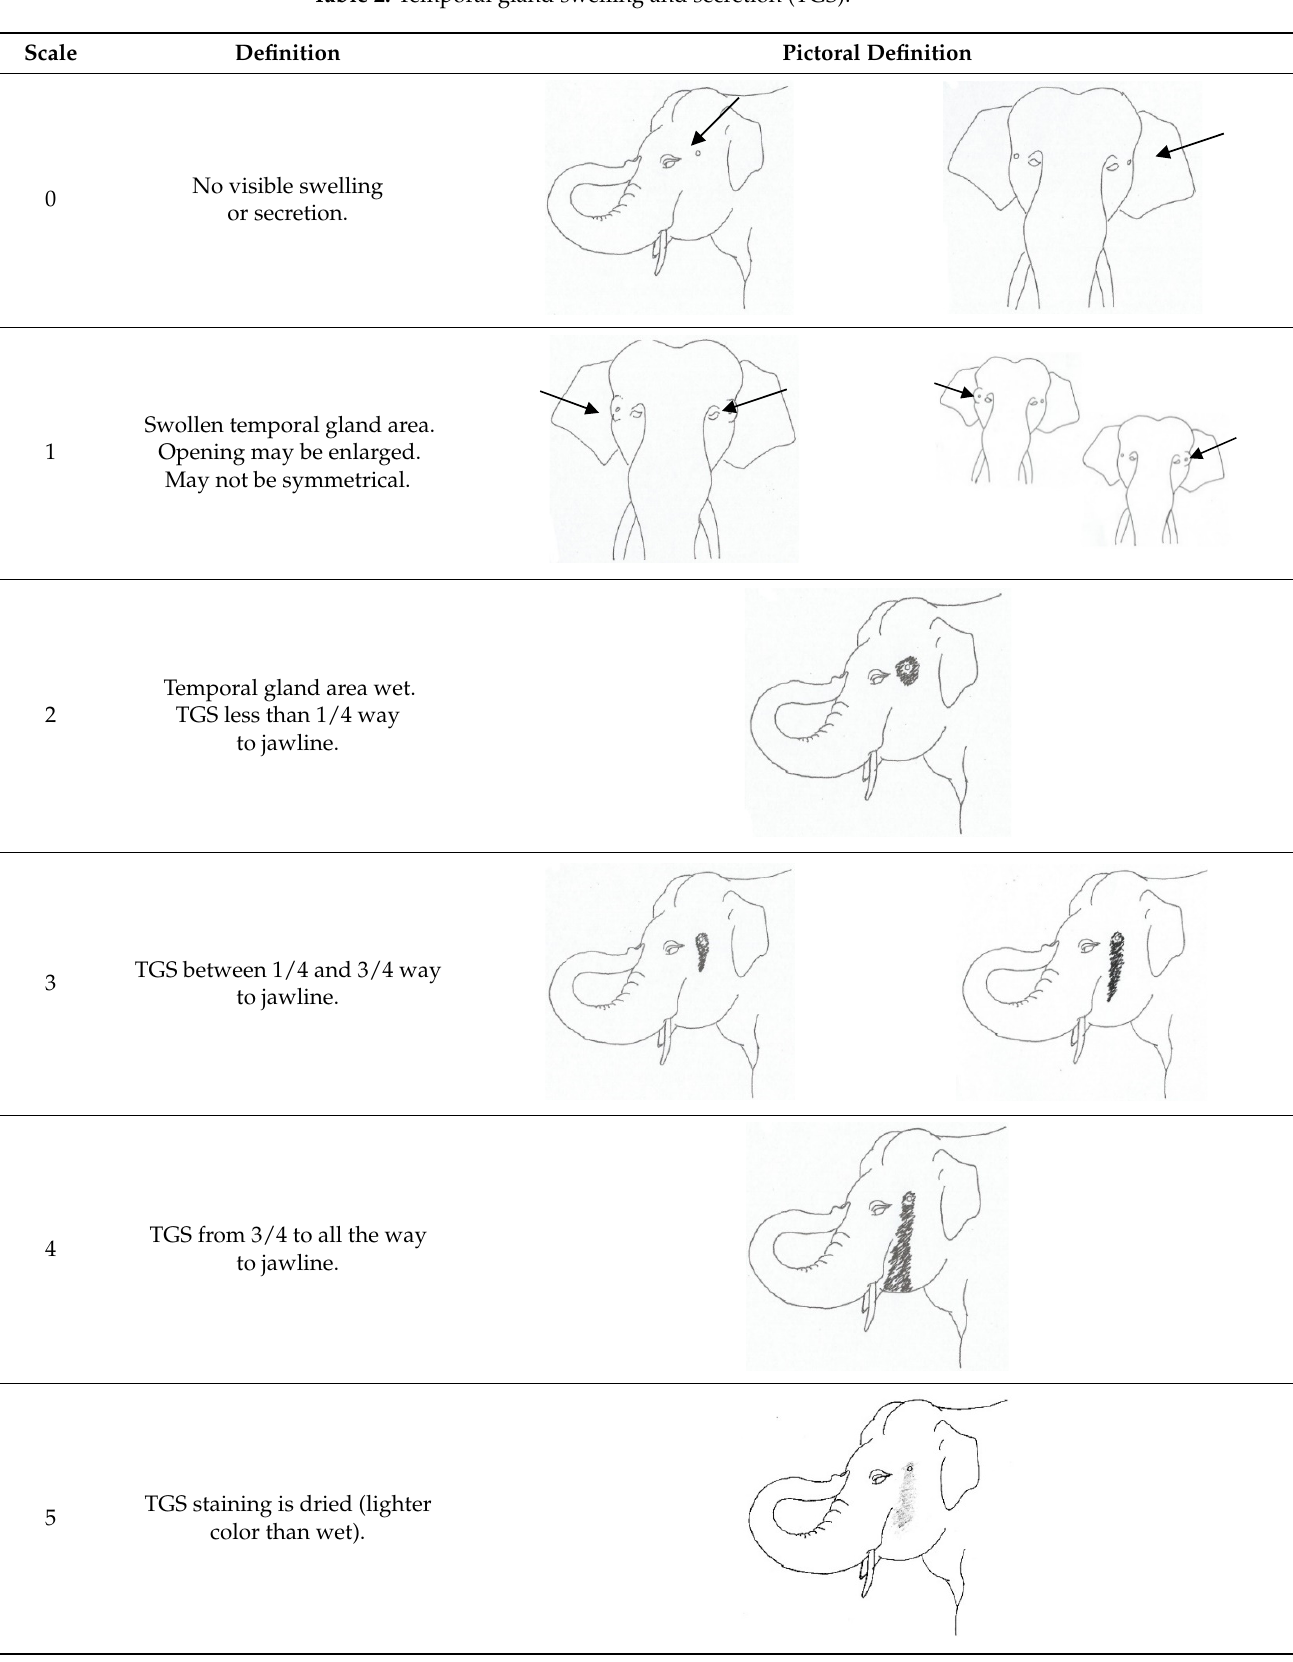
Table 4. Urine dribbling